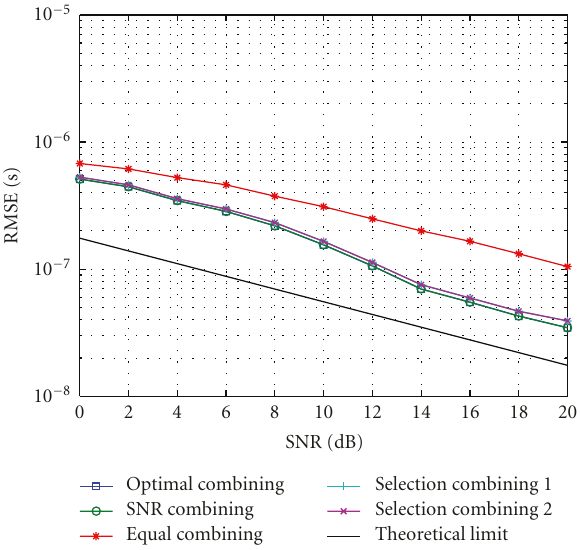
Figure 5: RMSE versus SNR for the proposed algorithms, and the theoretical limit (CRLB). The signal occupies two dispersed bands with bandwidths B 1 = 100 kHz and B 2 = 400 kHz.